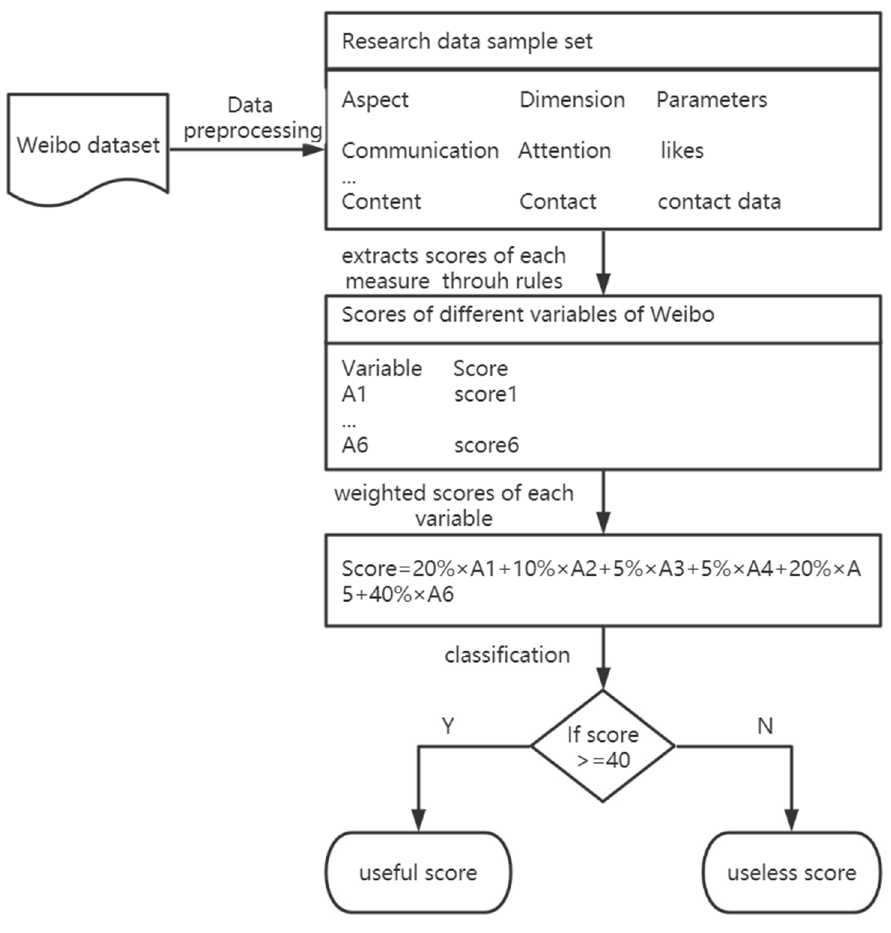
Figure 2. The flowchart of the rule-based classification program.